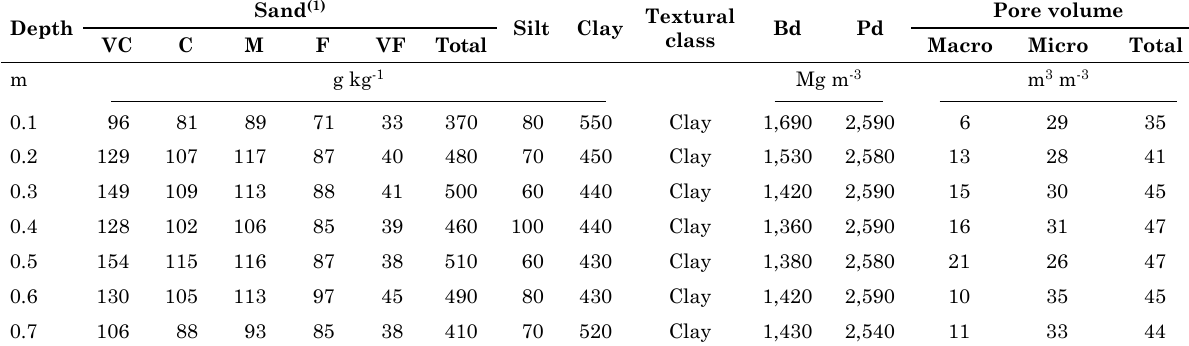
table 1. soil physical properties: granulometry, textural class, soil bulk density - Bd, particle density – pd, and pore volume (macropore - macro, micropore - micro, and total pore) in a Cambissolo Háplico